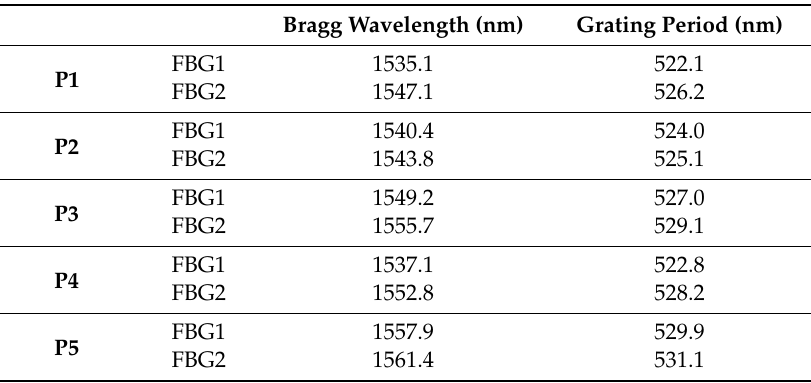
Table 1. Bragg wavelength and grating periodicity for each FBG.